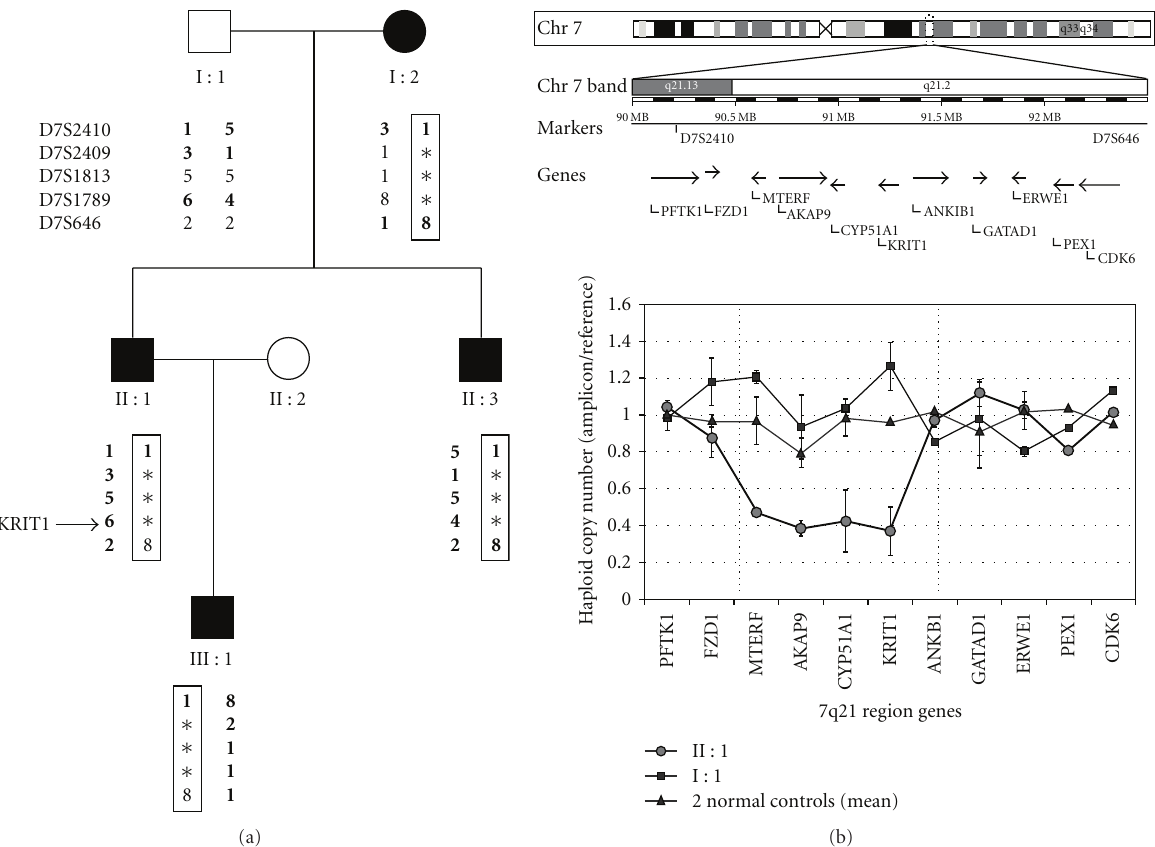
Figure 2: (a) Haplotype analysis of microsatellites markers from chromosome 7q21.1. The haplotype shared by the a ff ected individuals (black-filled symbol) is “boxed”. In the a ff ected patients, the symbol ( ∗ ) indicates the indefinite alleles, located in the deletion. Since the hemizygosity for the non shared alleles in the a ff ected patients, the analysis, shows “homozygosity” for three markers (D7S2409, D7S1813, D7S1789), thus, the deleted alleles are indicated with the same symbol ( ∗ ). (b) Measurements of copy number status ( ± standard error mean) of genes mapping in the 7q21 chromosomal region determined by RT-QPCR. On the Top: the genomic organization of genes. Genes are shown above the horizontal axis, which also indicates the extension and orientation of each gene. Results from normal genomic DNA (2 normal controls mean), from the una ff ected member of family (I:1 sample), and in one a ff ected members (II: 1) are visualized by a closed triangle ( (cid:2) ), a closed quare ( (cid:3) ), and a closed circle ( • ), respectively. The genes between the two vertical gray dotted lines show a hemizigous deletion detectable by the copy number loss of the associated